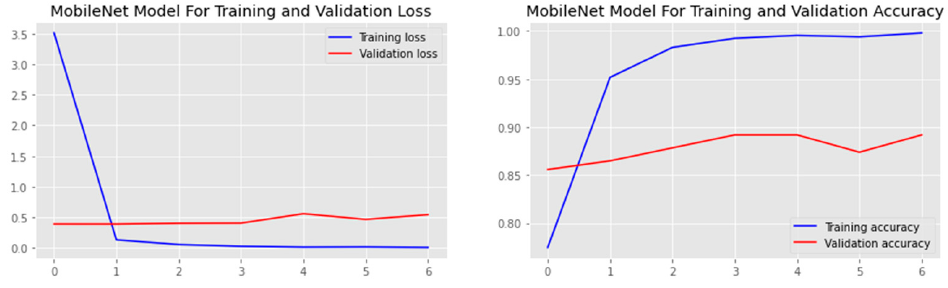
Figure 7. Accuracy and loss graph of the MobileNet model .